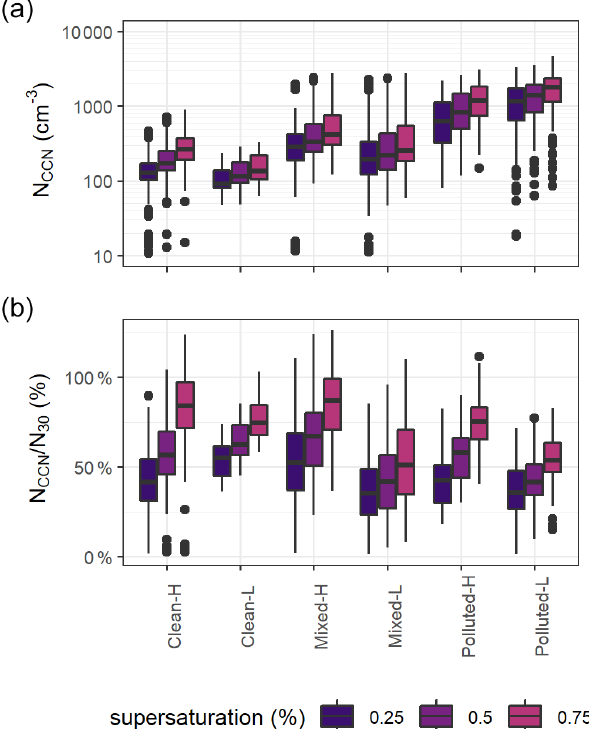
Figure 3. (a) The N CCN and (b) the activation ratio ( N CCN /N 30 ) at given supersaturations (SSs) for different types of air mass. The lines represent the median, the boxes represent the 25th to 75th quantile, the whiskers represent the 1.5 interquartile, and the points represent outliers. The colour codes represent the level of supersat- urations. Note the logarithmic Y axes in (a)